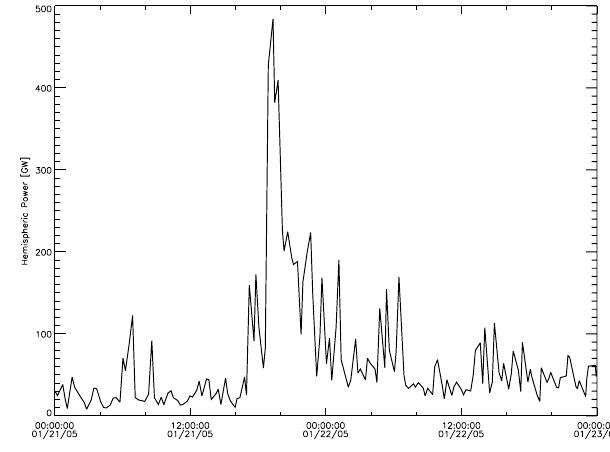
Fig. 4a. The time series of the Hemispheric Power from AMIE.